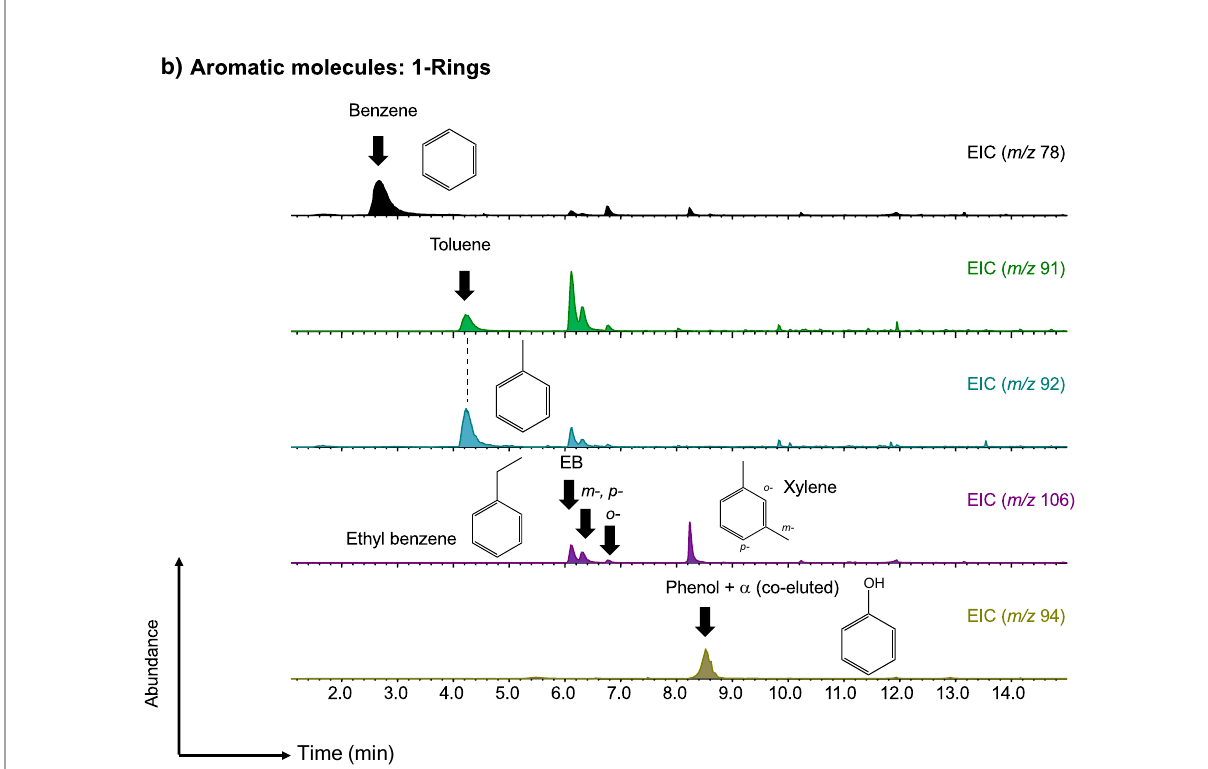
Fig. 6 TD-GC/MS chromatograms of a the aliphatic molecules ( n -alkanes); b – e aromatic molecules (e.g., monocyclic species: benzene, toluene, ethyl benzene, xylene, and phenol; bicyclic species: naphthalene, methyl naphthalene, dimethyl-naphthalene, and biphenyl; tricyclic species: phenanthrene, anthracene, methyl phenanthrene; and tetracyclic species: fluoranthene and pyrene); f heterocyclic molecules (e.g., dibenzofuran) from the quenched carbonaceous product without the sabot system (w/o sabot). Please see also Fig. 7 for a comparison of PAH profiles from the systems w/ or w/o the